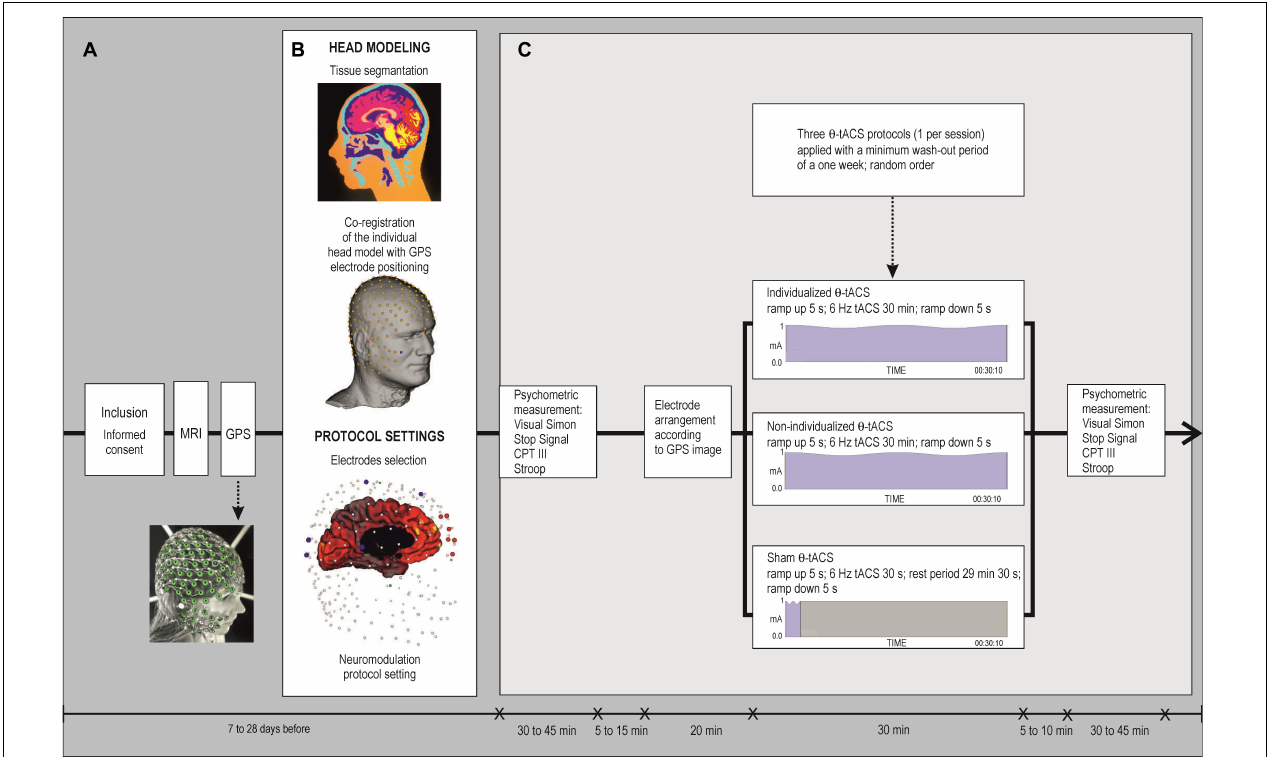
FIGURE 1 | Flow chart of the protocol. (A) Schematic overview of the study. (B) Illustration of head modeling with tissue segmentation, co-registration of an individual head model with GPS electrode positioning, and setting of a protocol to select the appropriate electrodes according to the individual cortical current density, followed by neuromodulation protocol settings. (C) Experimental procedure. A double-blind, cross-over study. Three neuromodulation sessions were carried out in random order with a minimum 1 week washout period. The psychometric measurement was tested immediately before and after the end of each neuromodulation session. Types of HD θ -tACS protocols: an individualized HD θ -tACS was targeted with the highest specificity to the mPFC-ACC; a non-individualized θ -tACS was targeted over the MFC with fixed electrode positions in the FCz and Pz areas; a sham tACS was administered with identical electrode montage (as used in the non-individualized protocol). Active θ -tACS sessions comprised a 5 s ramp up, 30 min of 6 Hz θ -tACS, and a 5 s ramp down. Sham condition comprised a 5 s ramp up and 30 s of 6 Hz θ -tACS followed by a 29 min 30 s rest period and a 5 s ramp down. Psychometric measurement was assessed by the Simon Task, Stop Signal Task, Conners’ Continuous Performance Test 3rd edition (CPT III), and the Stroop